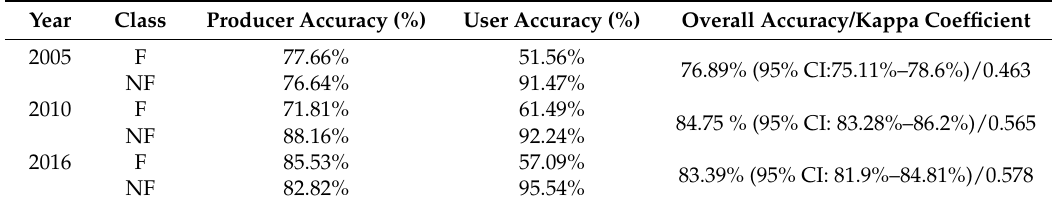
Table 4. The accuracy assessment of forest and non-forest in 2005, 2010, and 2016.